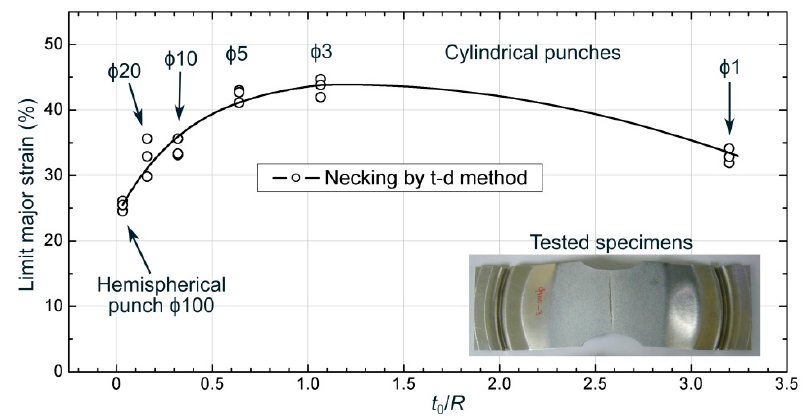
Figure 5. Limit major strain at necking versus t 0 / R ratio near plane strain conditions obtained using the t-d method.